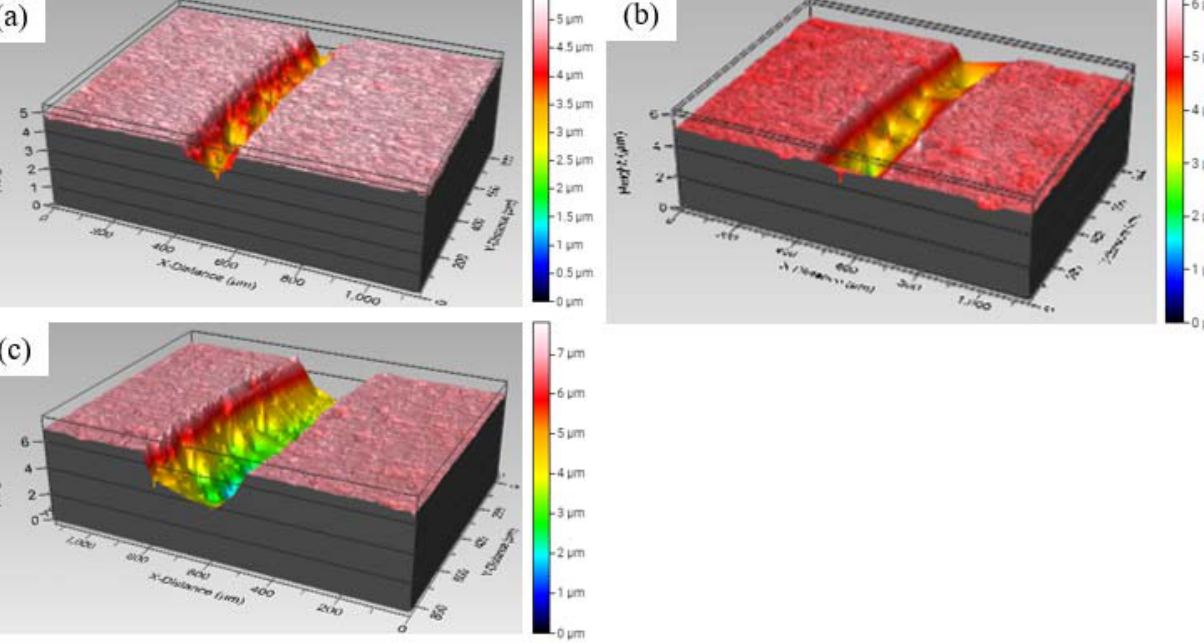
Figure 10. Three ‐ dimensional profilometer wear track images for ( a ) P 700/600°C , ( b ) P 700/800°C and ( c ) P 700/1000°C.